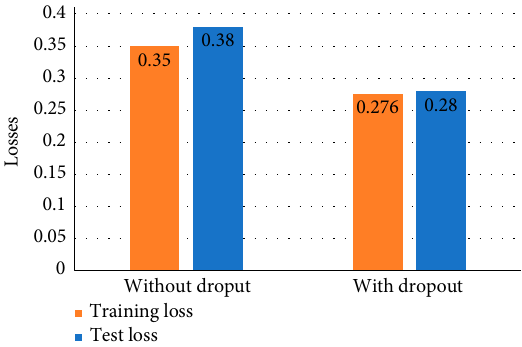
Figure 19: Effect of dropout on overfitting.